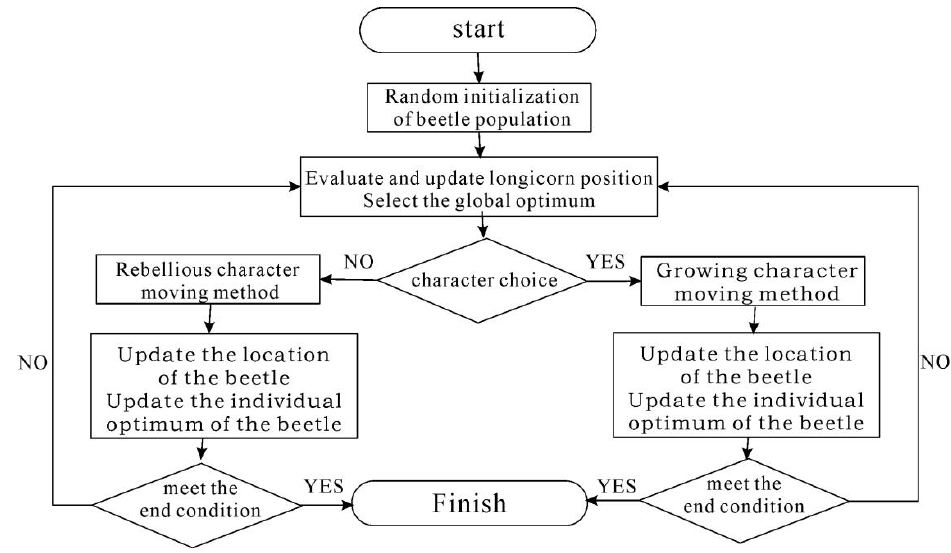
Figure 1. Algorithm flow